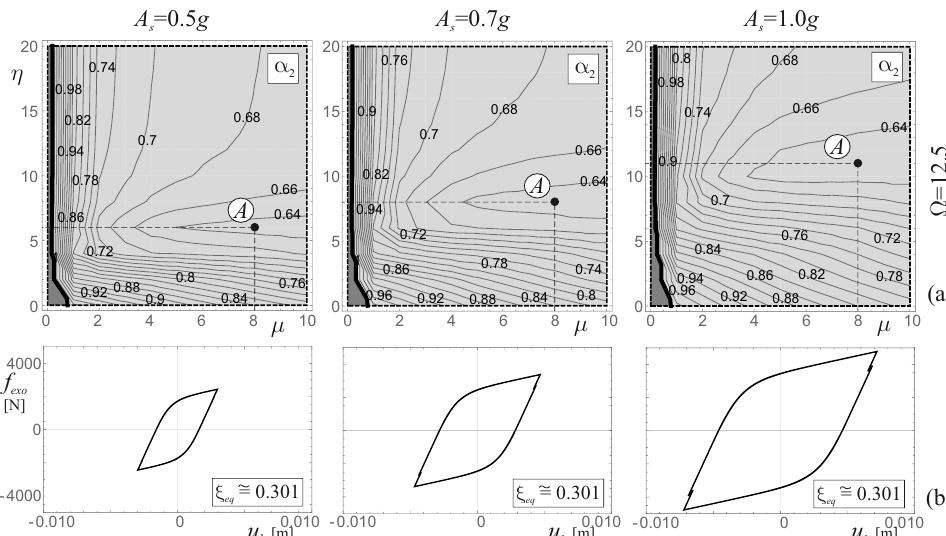
Figure 8. Gain maps for α 2 : ( a ) different amplitudes A S of the harmonic excitation; ( b ) stationary hysteretic cycles at the minimum point A of α 2 ( Ω = 12.5 rad/s, ψ = 0.1, γ =